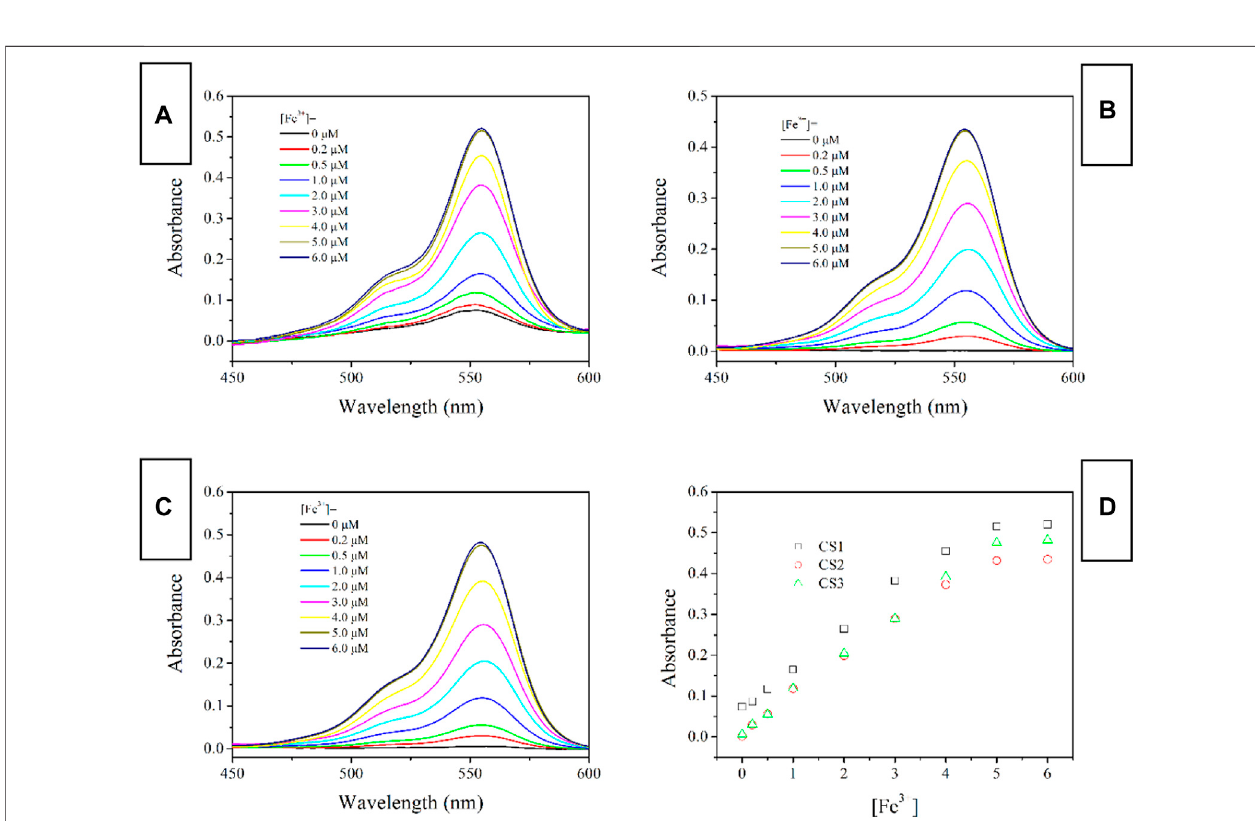
Frontiers in Chemistry |